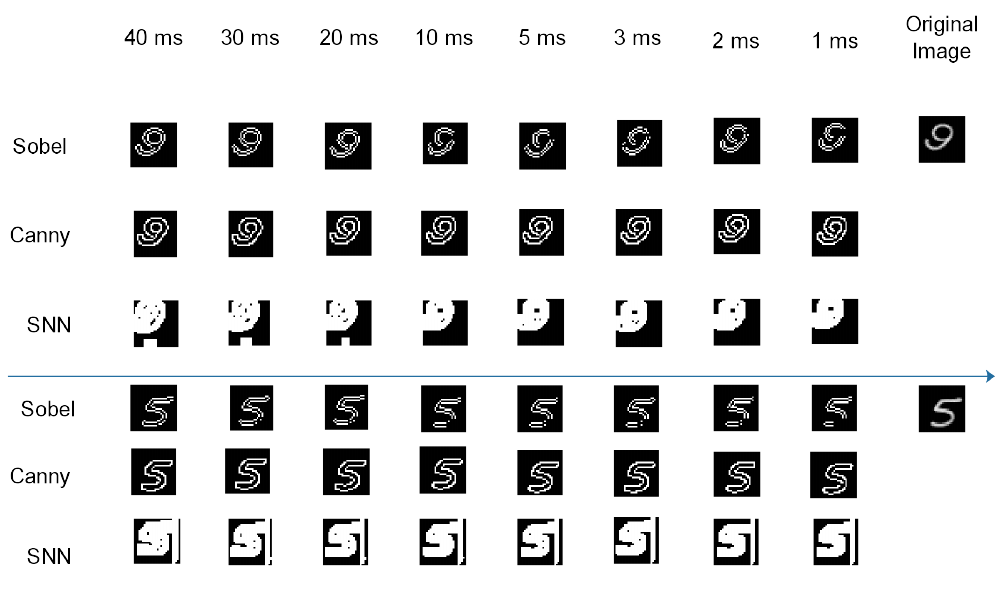
Figure 9. Comparison of edge detection methods for low exposure frames, t = 1 − 40 ms with an example image from Digits dataset.